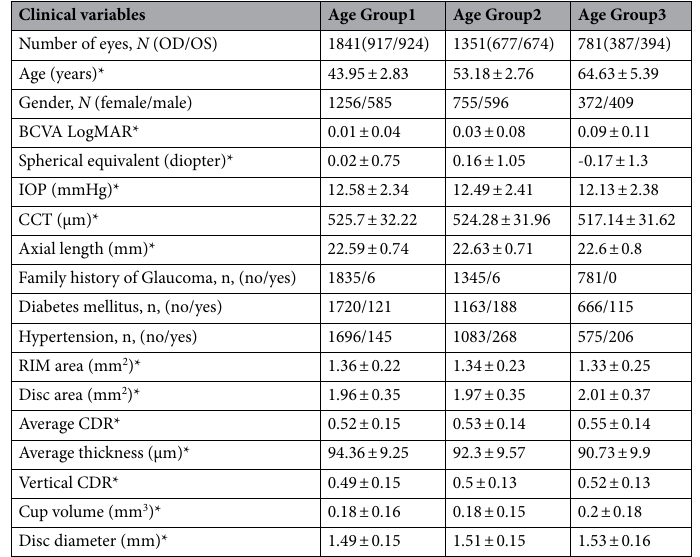
Table 1. The clinical variables of the study participants in the three age groups. The units are given in parentheses. The asterisk (*) denotes that a variable is described as mean ± sd. N number of samples, OD oculus dexter, OS oculus sinister, BCVA LogMAR best corrected visual acuity logarithm of the minimum angle of resolution, IOP intraocular pressure, CCT central corneal thickness, CDR cup-to-disc ratio, sd standard